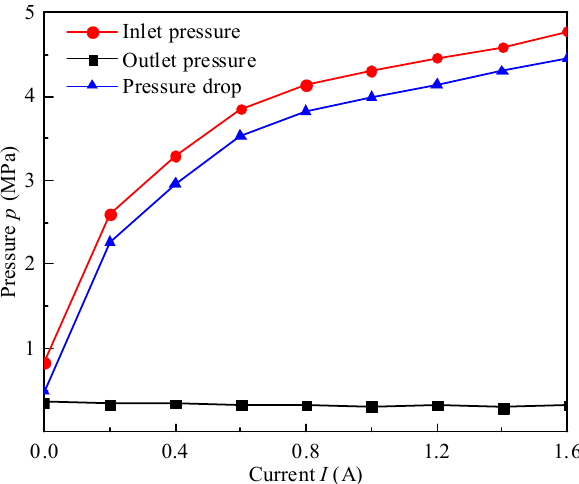
Figure 16. Pressure change of the optimal MR valve under different currents.